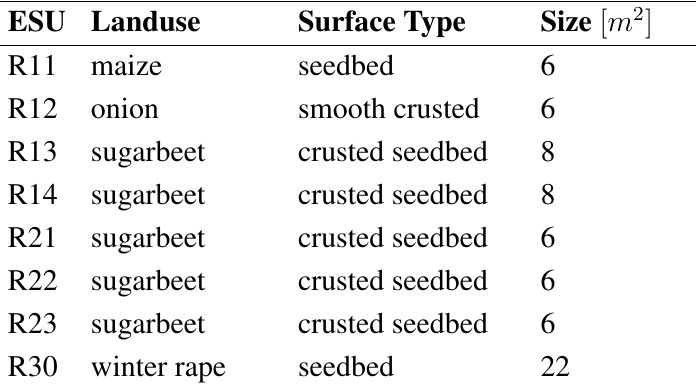
Table 5. Characteristics of sample points acquired within this study, ESU = E lementary S ample U nit .